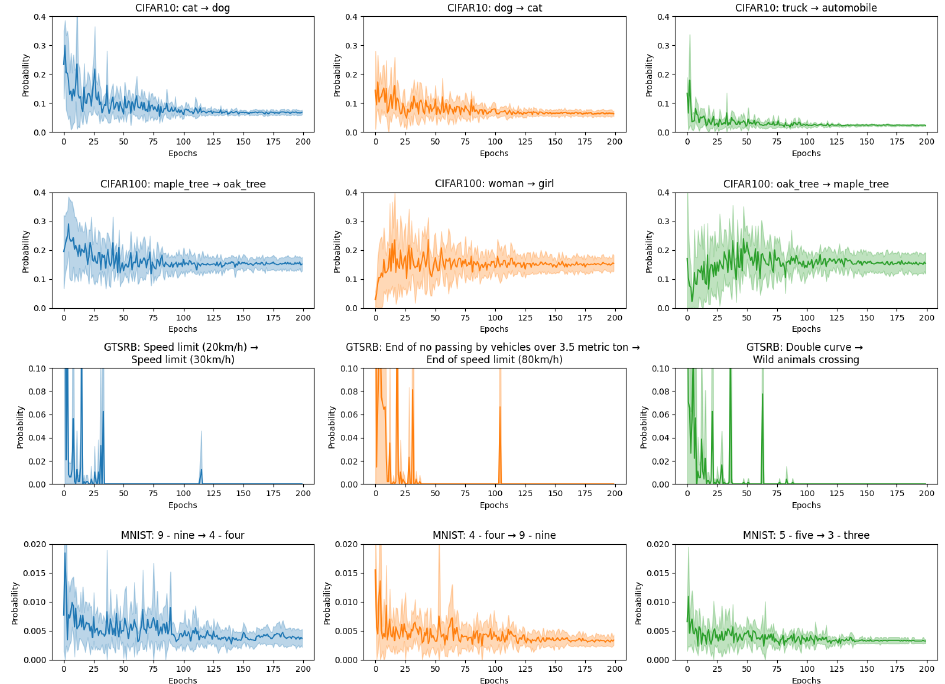
Figure 3. The evolution of misclassification probability for the three most common error types in each investigated